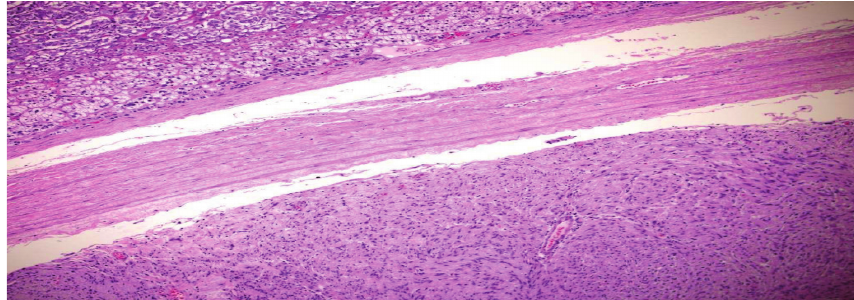
Figure 3: Adrenal (top), tumor capsule (middle), and schwannoma (bottom). H&E × 100.